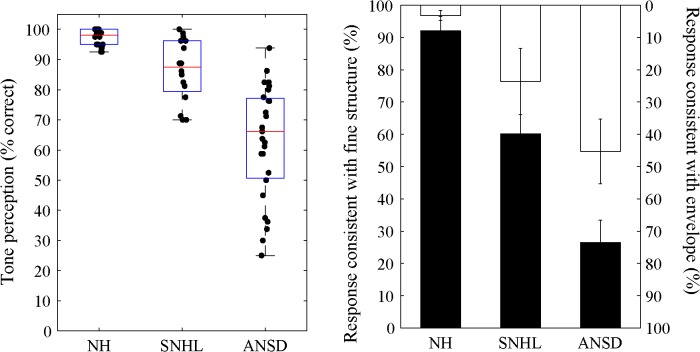
Tone perception performance with the original, unprocessed tone tokens (left) and with chimeric tone tokens (right) for subjects with NH, with SNHL, and with ANSD.Left: The horizontal lines represent 25th, 50th, and 75th percentiles and the whiskers represent the range of the data. Individual subjects are represented by the solid dot. Right: Bars represent mean percentages of the tone responses consistent with FS (filled bar, left ordinate) and E (open bar, right ordinate) for the three groups of subjects. Error bar represents standard deviation.